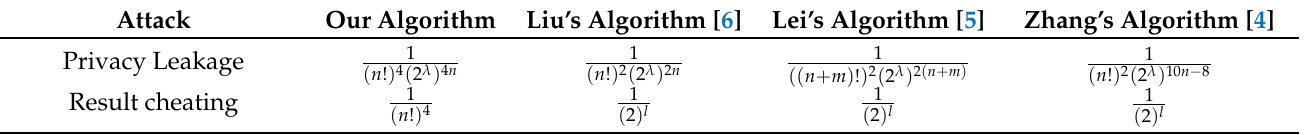
Table 6. Probability of successful